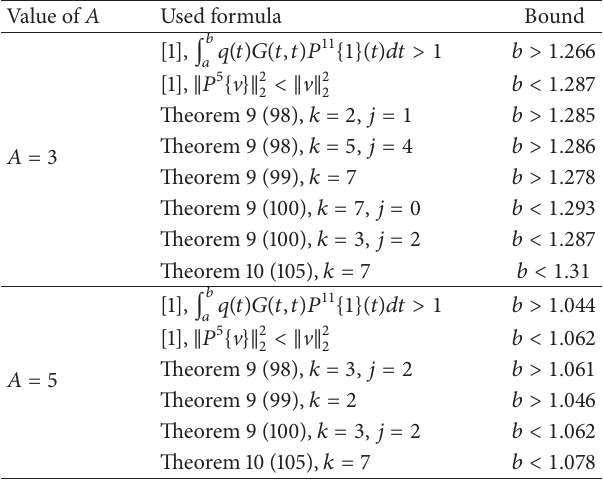
Table 1: Comparison of bounds for 𝑏 in Example 1. Value of 𝐴